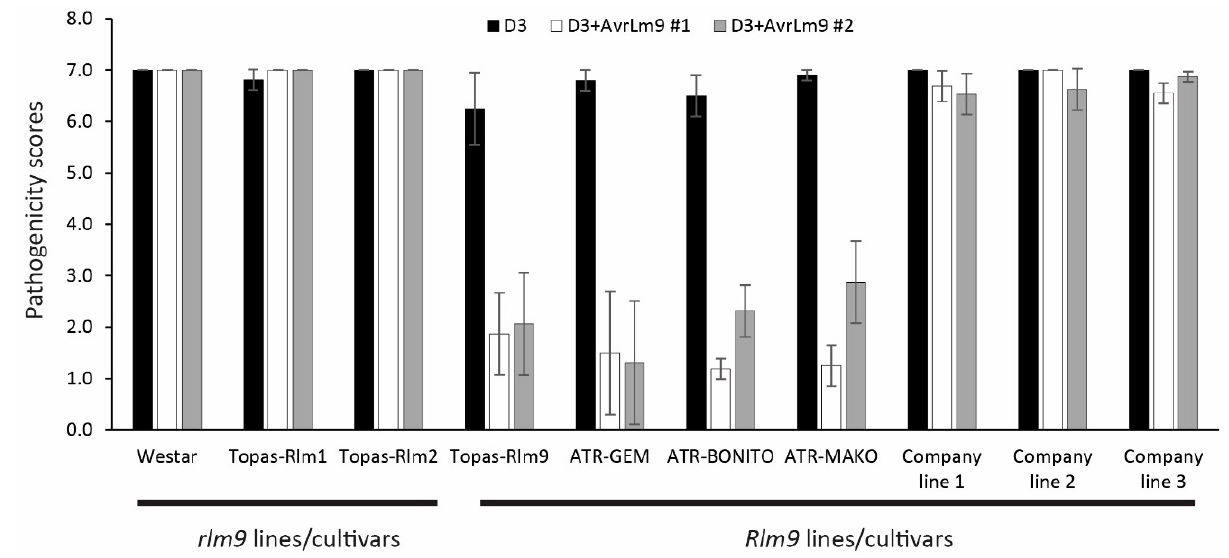
Figure 2. Confirmation of the Rlm9-AvrLm9 interaction in B. napus lines/cultivars with differential addition isolates (DAI). Isolates D3+AvrLm9 #1 and D3+AvrLm9 #2 are avirulent towards Rlm9 due to transformation of the progenitor isolate, D3, with AvrLm9 . The rlm9 cultivars/lines were susceptible to all isolates as expected. The Topas- Rlm9 , ATR-Gem, ATR-Bonito and ATR-Mako lines were all resistant to the DAI isolates as expected, due to the presence of the Rlm9 allele. Company line 1–3 unexpectedly showed a susceptible reaction to all isolates despite genotypically harboring the Rlm9 allele. Error bars represent the standard error from eight replicate plants.